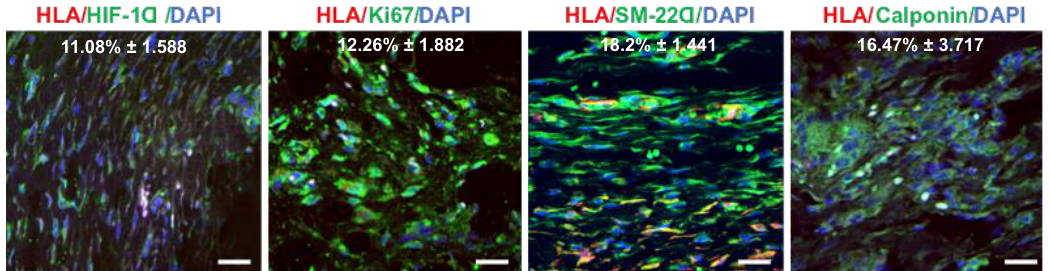
Figure 8. In vivo viability and phenotype of hiPSC-VSMCs in the wound microenvironment. Immunofluorescence of explanted tissue from hiPSC-VSMC-treated groups using (i) HLA/calponin, (ii) HLA/SM-22α, (iii) HLA/Ki67, and (iv) HLA/HIF-1α. Dapi was used to stain nuclei. Scale bar represents 50 µm. Data ( n = 4) are presented as mean ± SEM.